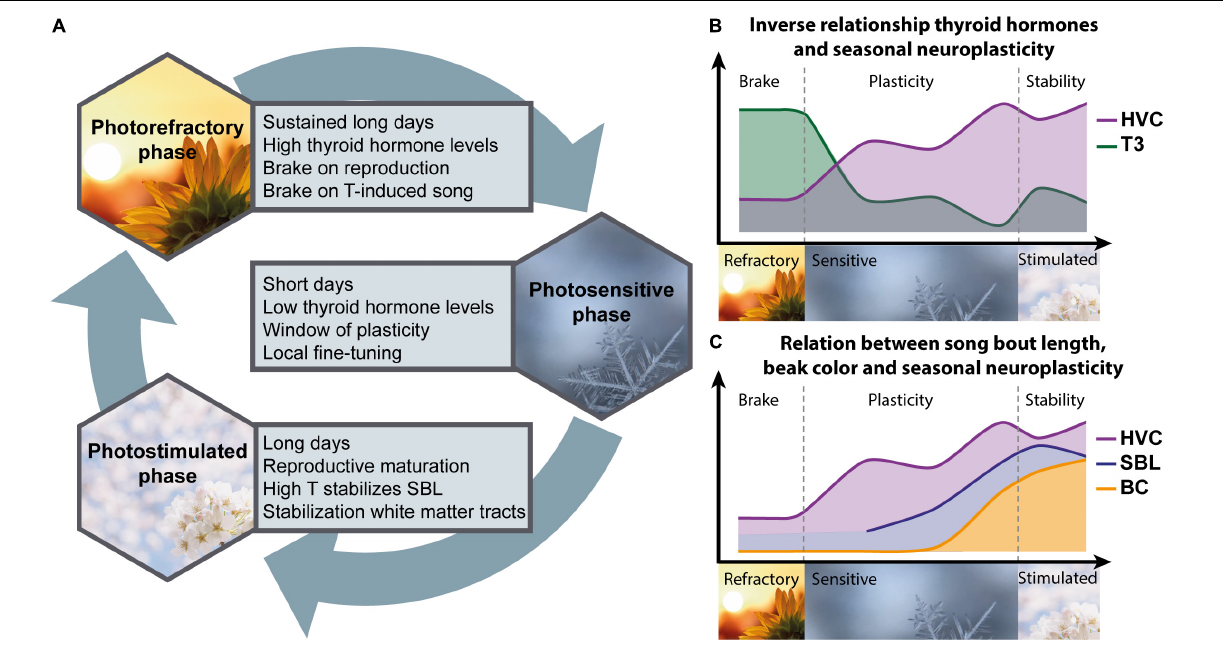
FIGURE 9 | Schematic overview of the main interactions between thyroid hormones, song behavior and neuroplasticity across the different seasons (A) . During the photorefractory period, circulating thyroid hormone levels are high, sustaining brakes on reproductive maturation and testosterone (T) induced singing behavior. These brakes are lifted as the day length and thyroid hormones decrease during the photosensitive period, leading to a window of neuroplasticity, indicated by the inverse relationship between thyroid hormones and microstructure changes in song control nuclei like HVC (B) . Furthermore, during this photosensitive period beak color (BC), song bout length (SBL) and HVC microstructure start to increase gradually and are positively correlated to each other (C) . Even though the circulating concentrations of T and thyroid hormones are low, their effects might be maximized by local fine-tuning through upregulation of aromatase in the telencephalon (Riters et al., 2001) and thyroid hormone transporter LAT1 in HVC. Subsequent long day photostimulation will result in reproductive maturation, which requires thyroid hormones. The resulting peak in circulating testosterone stimulates the song rate and stabilizes the song bout length. High DIO3 expression in the